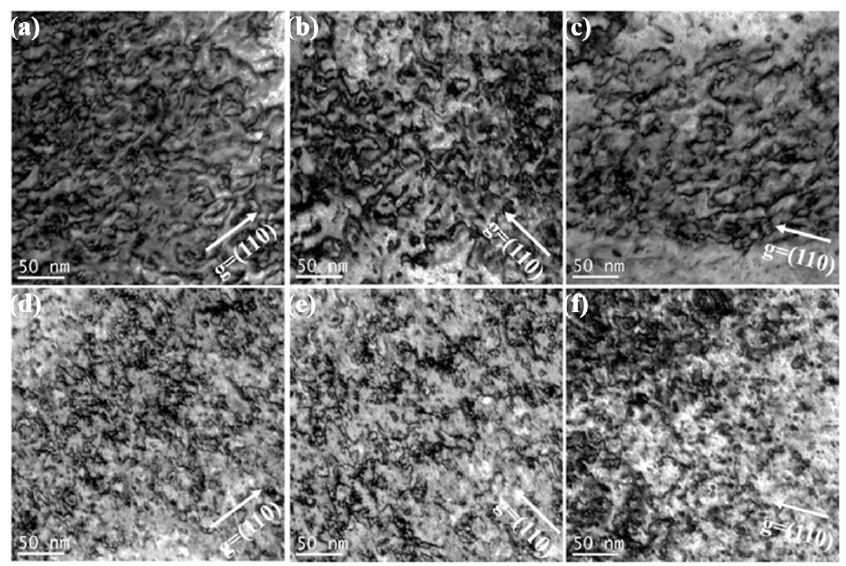
Figure 5. The dislocation loops distribution of three grade samples in different depth with g vector of <110> after 1.5 × 10 15 Au + /cm 2 irradiation: ( a – c ) corresponds to 100 nm, ( d – f ) corresponds to 200 nm.